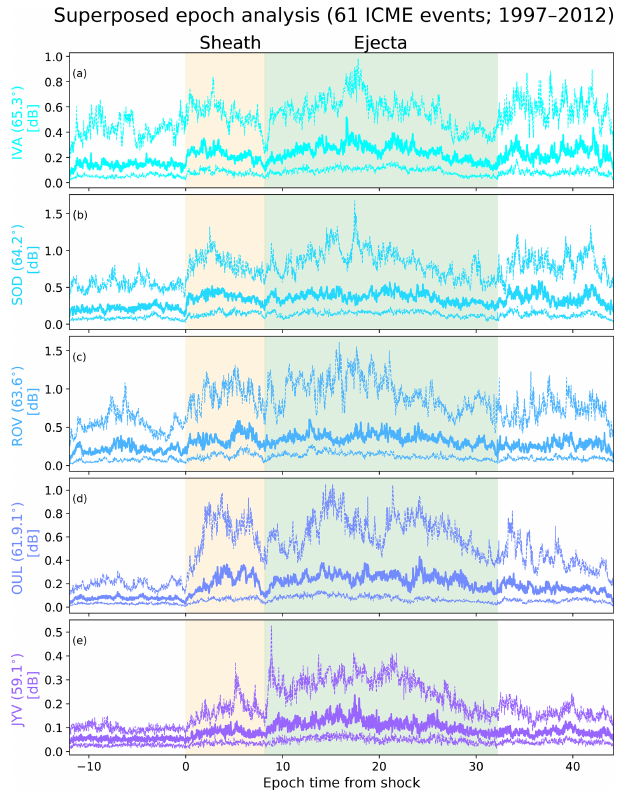
Figure 5. Superposed epoch analysis of CNA for 61ICME events occurring between 1997 and 2012. The thick curves show the me- dian, and thinner curves show the lower and upper quartiles. The data are shown for five stations in the SGO chain (Ivalo, Sodankylä, Rovaniemi, Oulu, and Jyväskylä) that are organized according to their MLAT from highest to